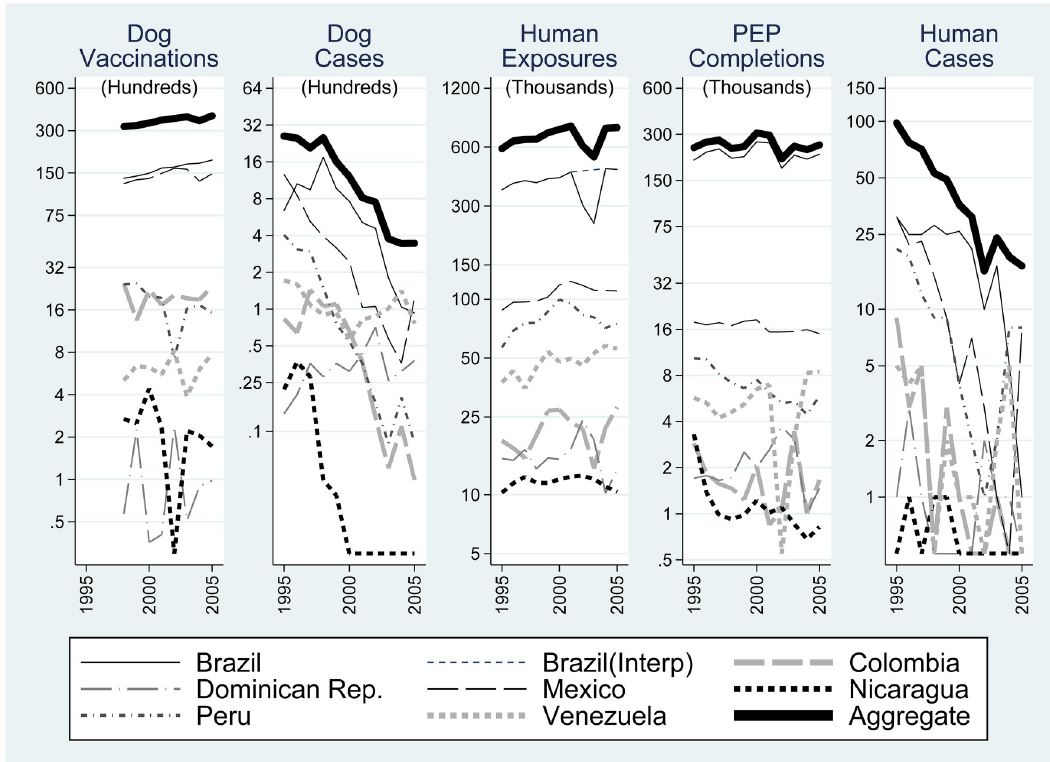
Fig 2. Time series of the five focal variables for each of the seven countries, and the sum across countries. Natural log scale. “Brazil (Interp)” interpolates over a data anomaly in Reported Human Exposures discussed in the data section of supplemental